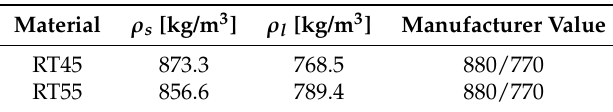
Figure 11. Schematics of the procedure to calculate the density. Table 6. Density